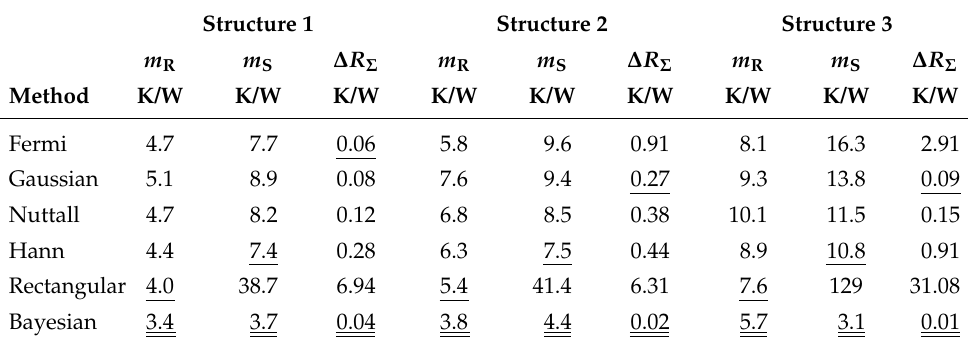
Figure 5. Various attempts (gray curves) for the cut-off frequency, Φ c , in a network identification using a Gaussian filter (35) for a fixed value of σ . Filter 1 is too narrow, filter 11 is too wide, while filter 8 yields the best result. For comparison, the ideal result for structure 2 is shown. Table 3. Best accuracy for all methods in the absence of noise. The best performing method in each column is double underlined, the second best result is underlined. The first five methods denote selections for the window functions, F Window